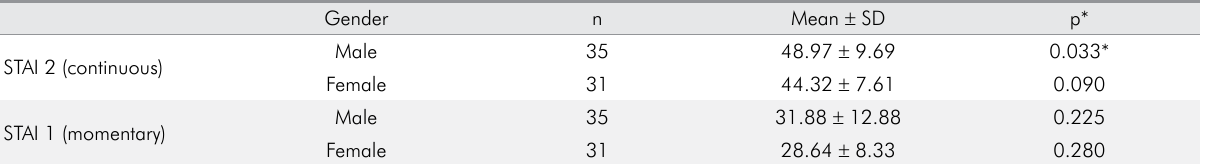
Table 4. Scores on the state-trait anxiety inventory (STAI) 1 (momentary) and STAI 2 (continuous) tests according to gender of the